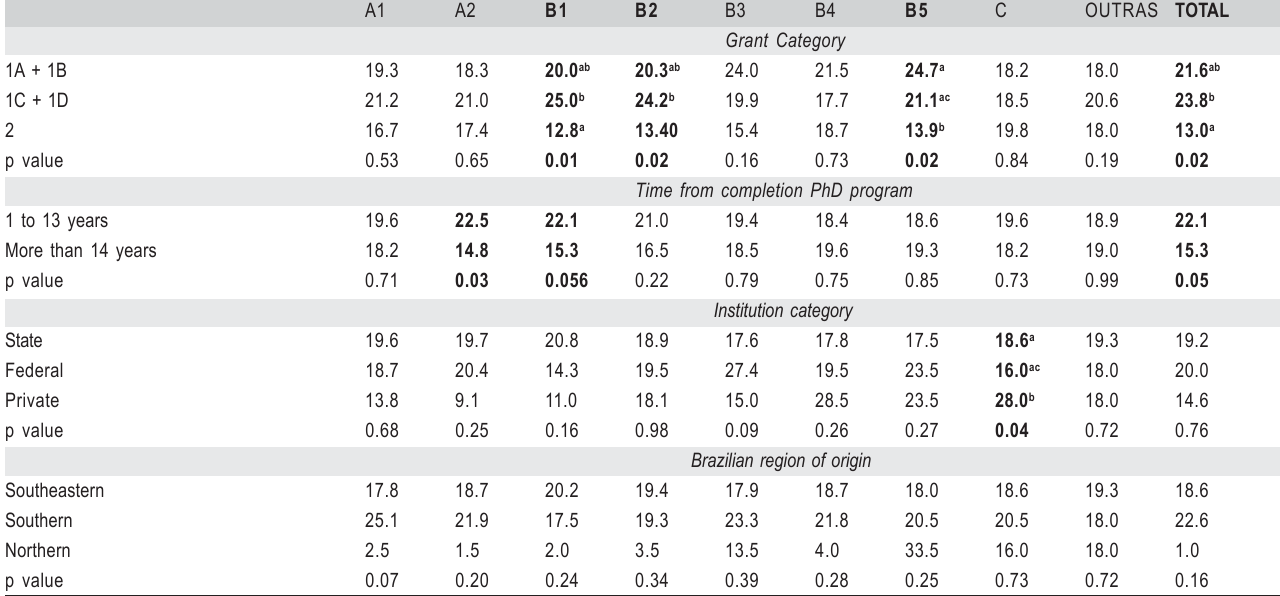
Table 4. Number of published papers by year of completion of PhD program and grant categories, time since completion of PhD program, affiliated institution and Brazilian region